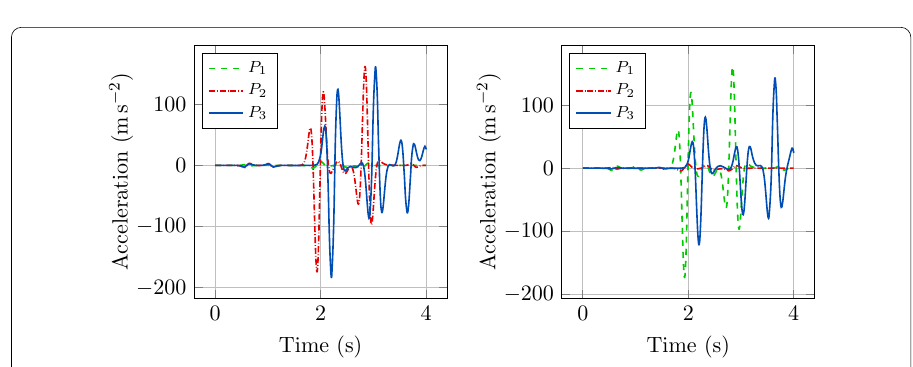
Fig. 6 Time evolution of the acceleration field in a homogeneous isotropic medium in three locations (see Fig. 5 for locations). Left: x direction. Right: y direction